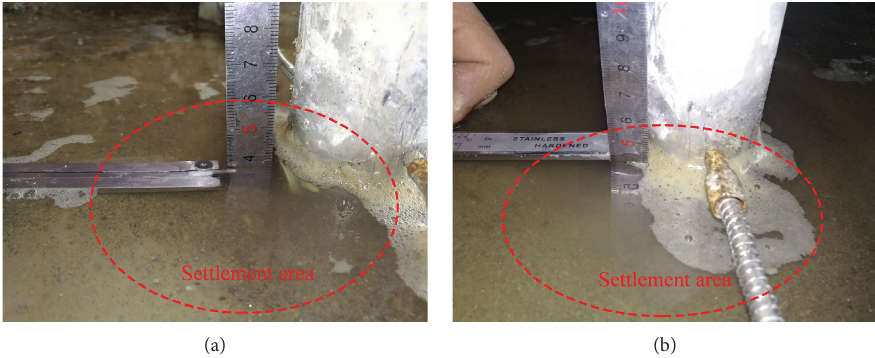
Figure 17: Settlement with different cycles around pile in case 6: (a) N � 1000 cycles; (b) N � 5000